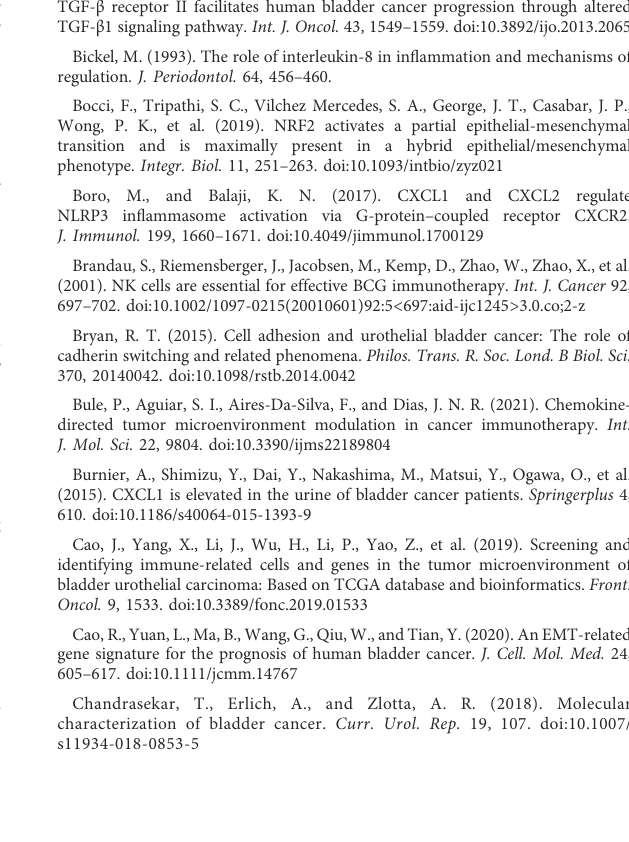
fi gure and the table. MPC and CJ draftedandrevised the paper. RB, UC, and LA revised the paper. All authors read and approved the fi nal